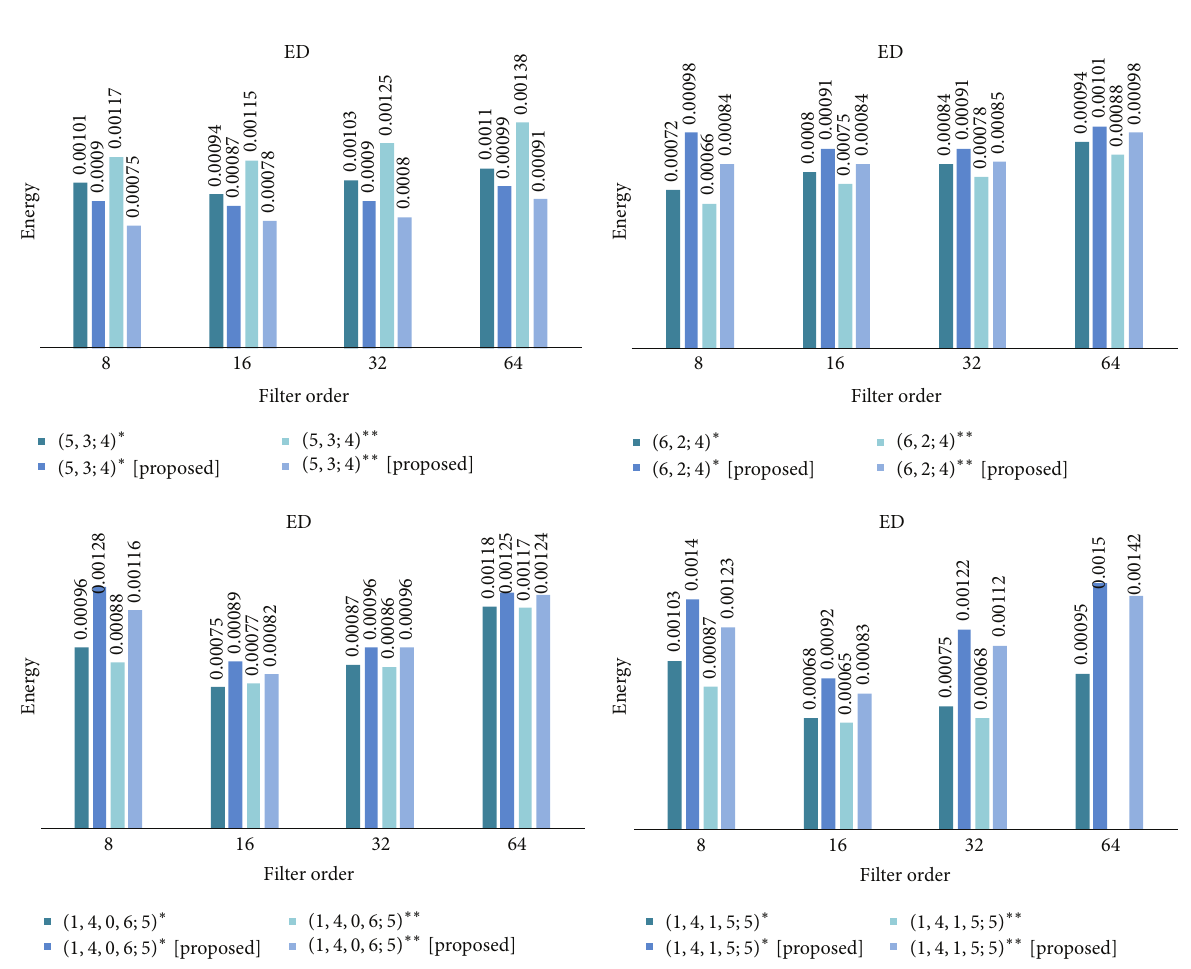
Figure 19: Energy density (in nJ/LUT) for filters based on different GPCs on Kintex-7